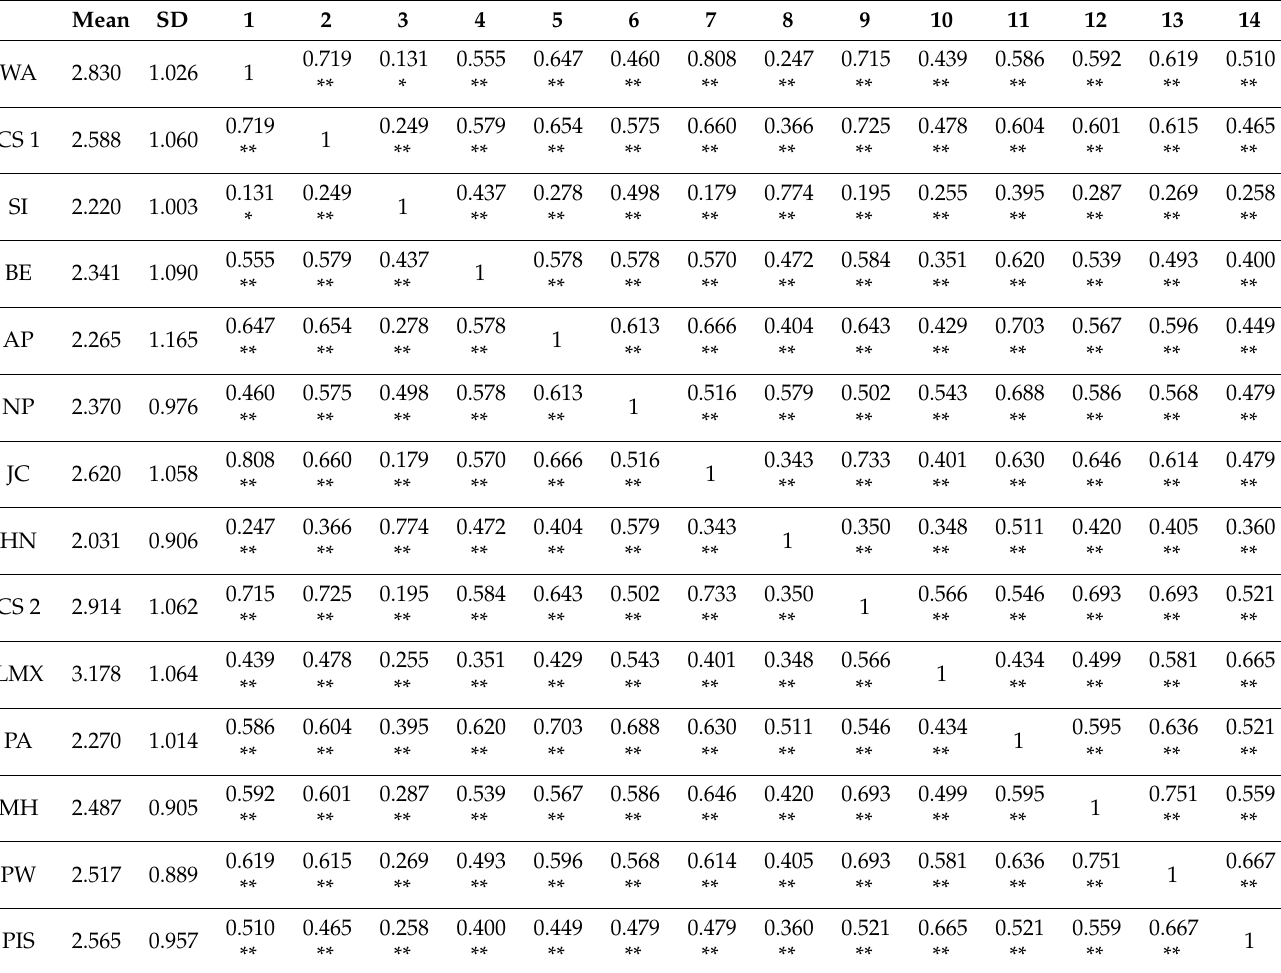
Table 6. Result of Pearson correlation